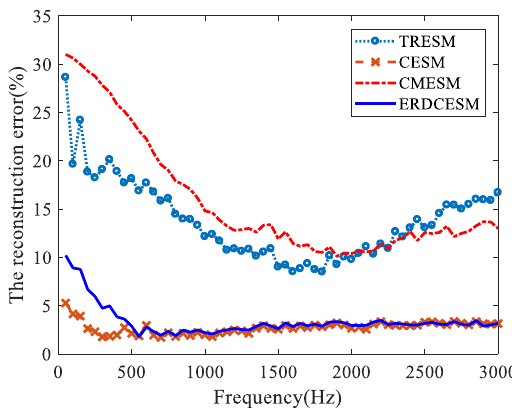
Figure 3. Reconstructed error for a single sound source. Frequency interval is 50 Hz.